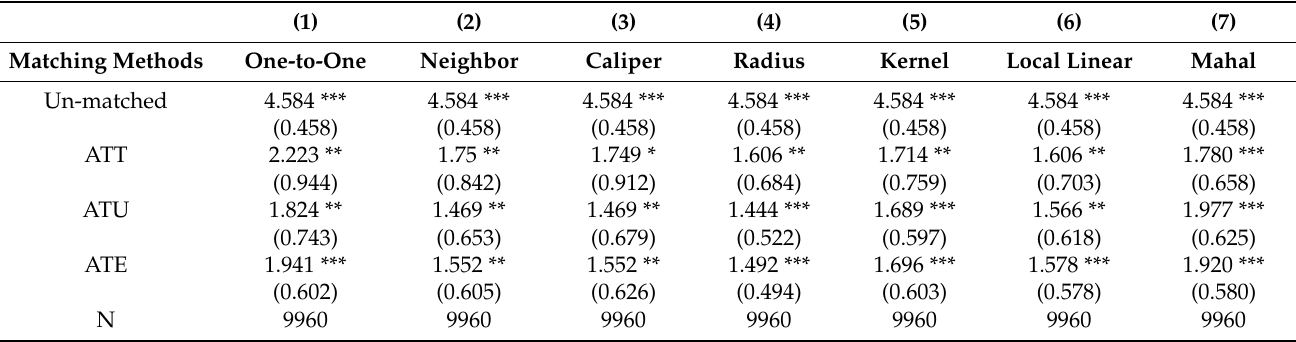
Table 3. Results of PSM estimation on treatment effect of solid cooking fuel